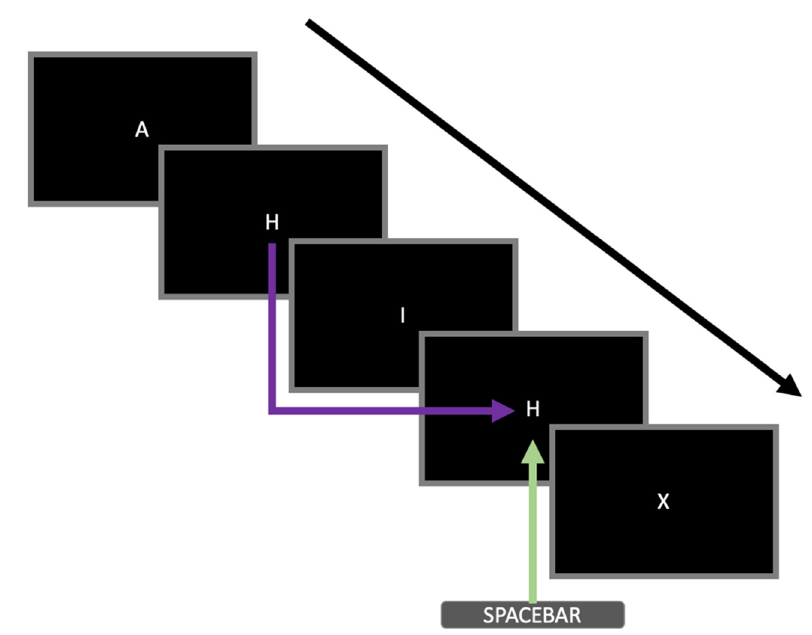
Figure 1. An example of a sequence of stimuli presented during the 2-back task adopted in this study. Five trials are shown in this figure. The black arrow represents the temporal sequence of the letters presented during the task. The purple arrow highlights that the particular stimulus was identical to the stimulus two trials back (i.e., matching trial). The green arrow indicates that the participant had to respond by pressing the spacebar during that particular